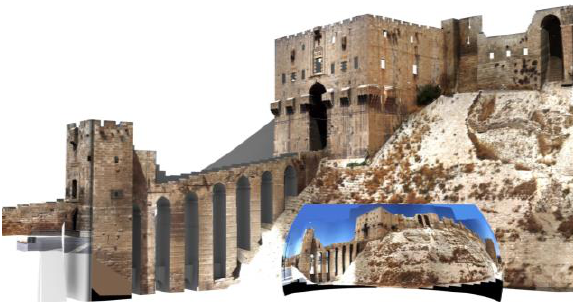
Figure 33 – The lay-out of the orientation network of the 22 panoramas